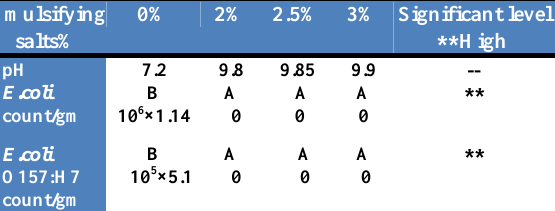
Table, 5: Count rates E.coil O157:H7/ g samples nutrient broth Effect ratios emulsifying salts.